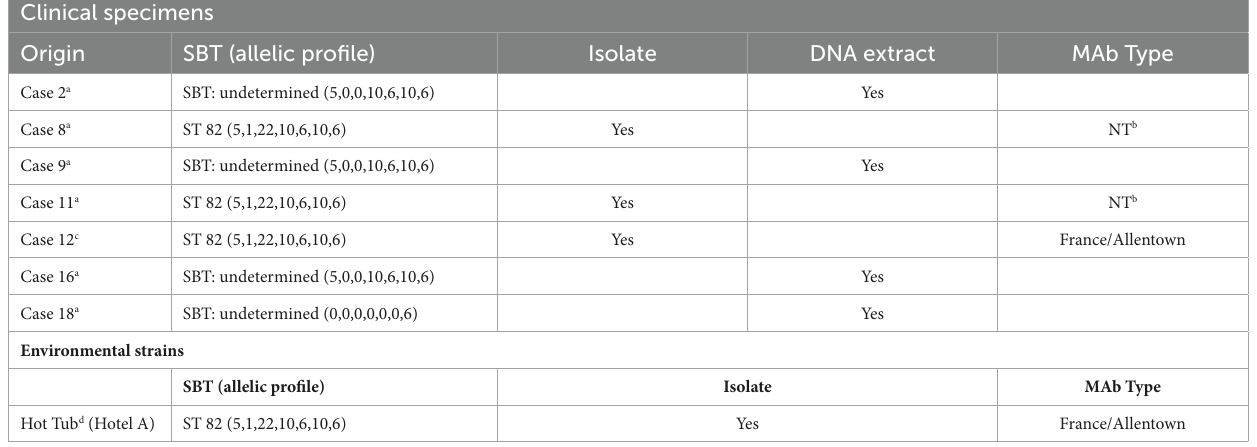
TABLE 1 SBT profiles and MAb types of the relevant clinical specimens and environmental strains. Clinical specimens